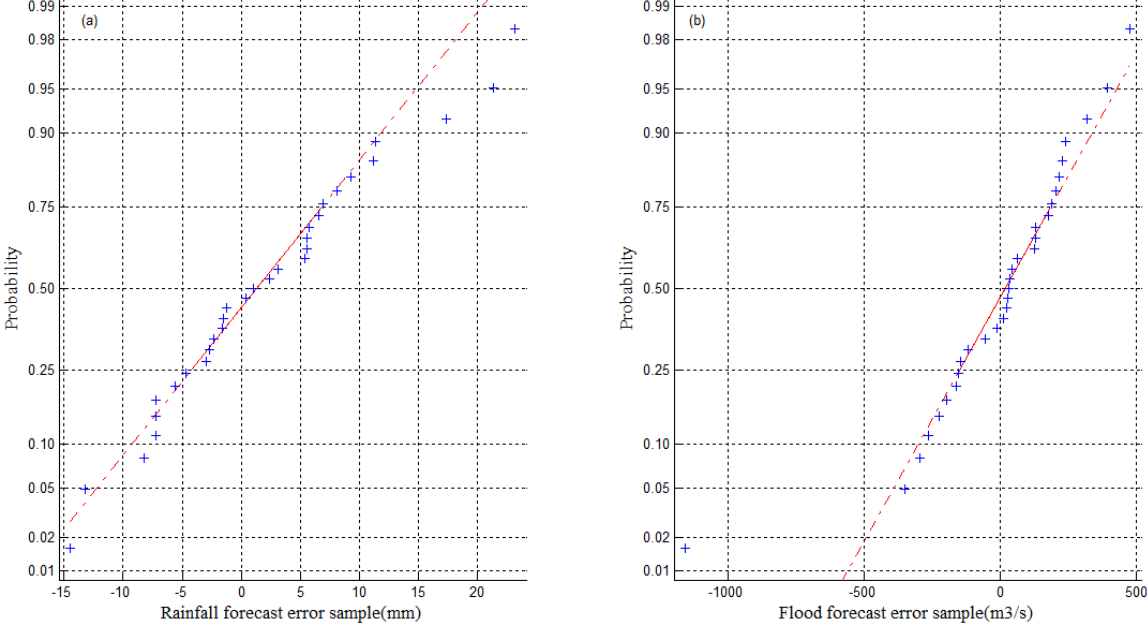
Figure 3. Normal distribution test for ( a ) rainfall forecast error sample; and ( b ) flood forecast error